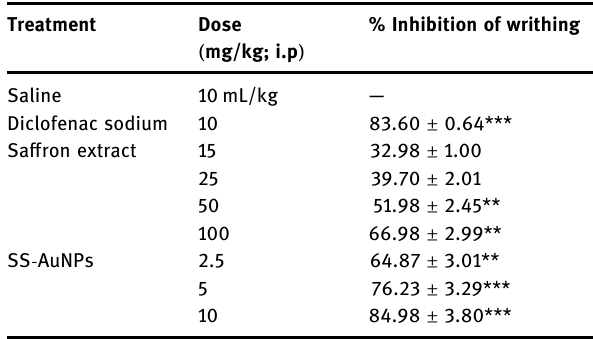
Table 2: Urease inhibition e ff ect of sa ff ron extract and SS - AuNPs Samples/standard Table 3: Carbonic anhydrase - II inhibition e ff ect of sa ff ron extract and SS - AuNPs Samples/standard Table 4: α - Chymotrypsin inhibition e ff ect of sa ff ron extract and SS - AuNPs